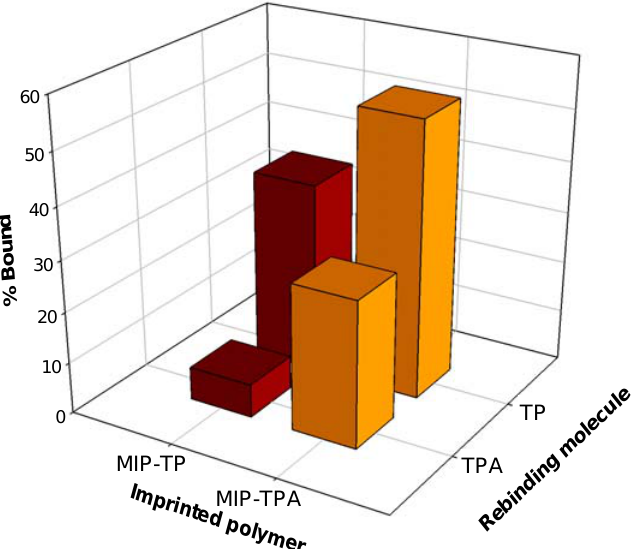
Figure 4. Cross-selectivity of MIP-TP and MIP-TPA with templates TP and